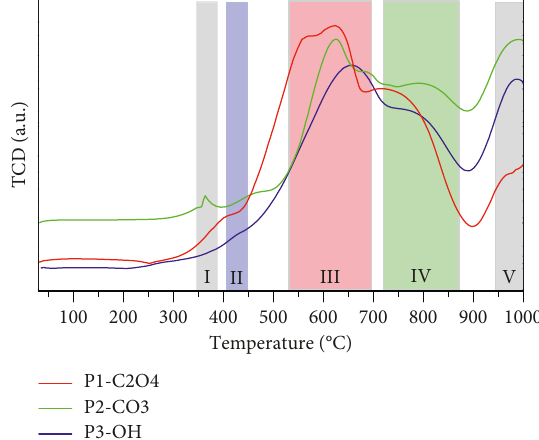
Figure 7: Temperature-programmed hydrogen reduction profile for the samples P1-C2O4, P2-CO3, and